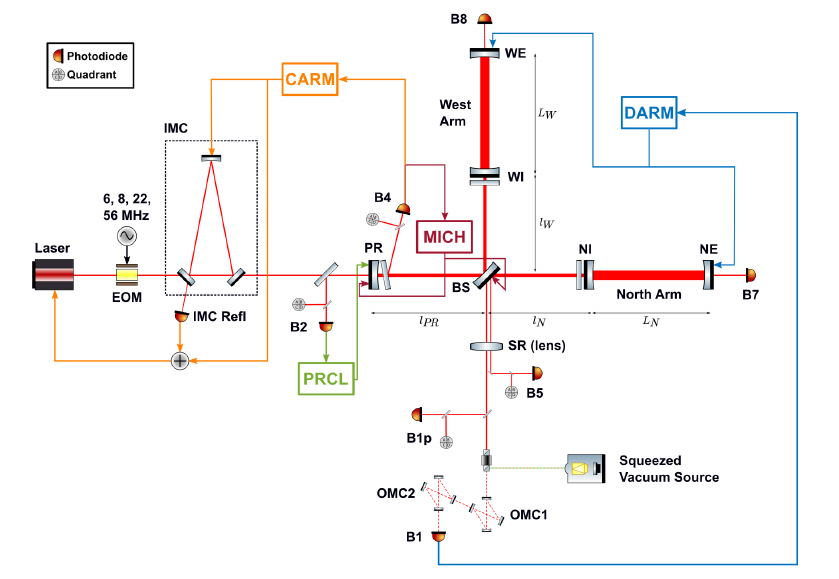
Figure 2. Optical layout of Advanced Virgo during O3. Each depicted Quadrant Photodiode (QPD) actually represents a set of two different physical sensors [89]. DARM, CARM, MICH and PRCL refer to the longitudinal degrees of freedom (cf. Section